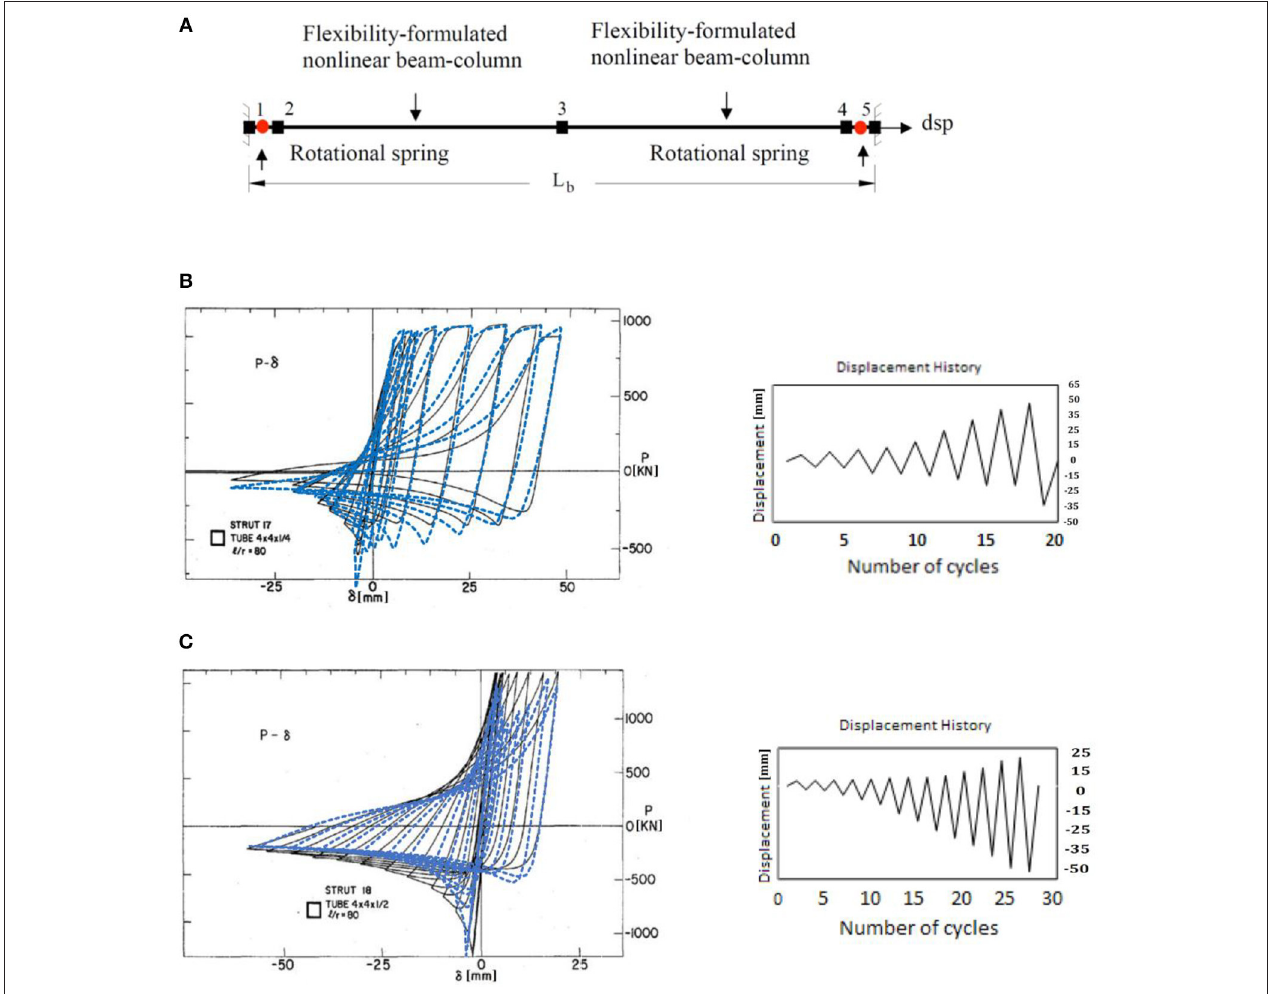
FIGURE 3 | (A) Finite element model used to calibrate with experimental tests (Yang et al., 2009b). (B) Comparison of analytical (dashed line) and experimental (solid line) hysteretic responses of HSS4x4x1/4 and (C) HSS4x4x1/2 struts and their corresponding displacement